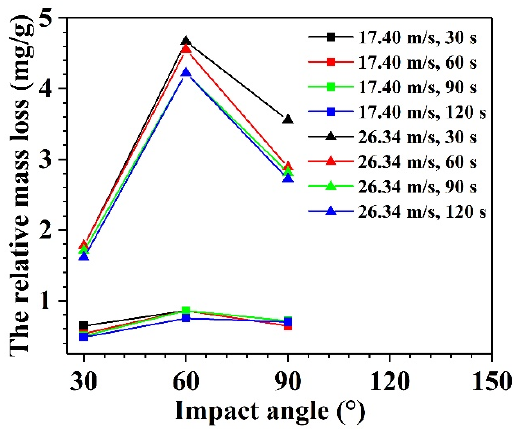
Figure 7. Relative mass loss of glass specimens with increase in impact angle.